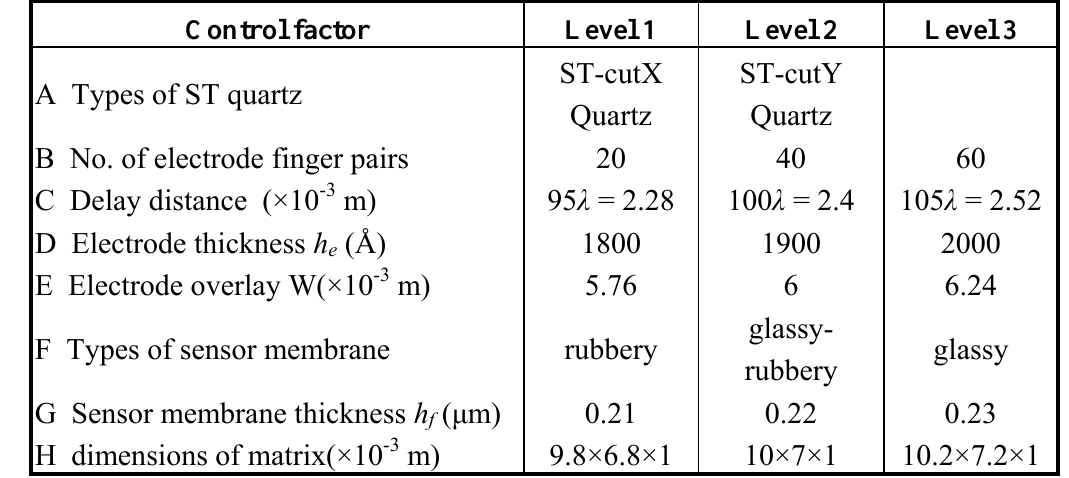
Table 1. Control factor and